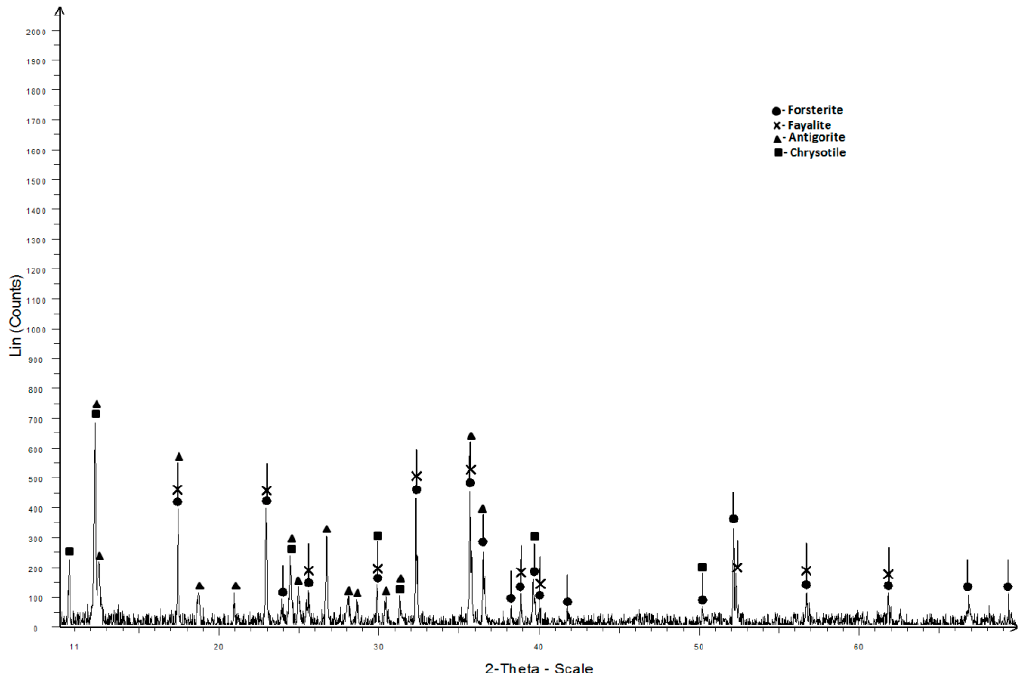
Figure 2. X-ray diffraction pattern of dunite sand.